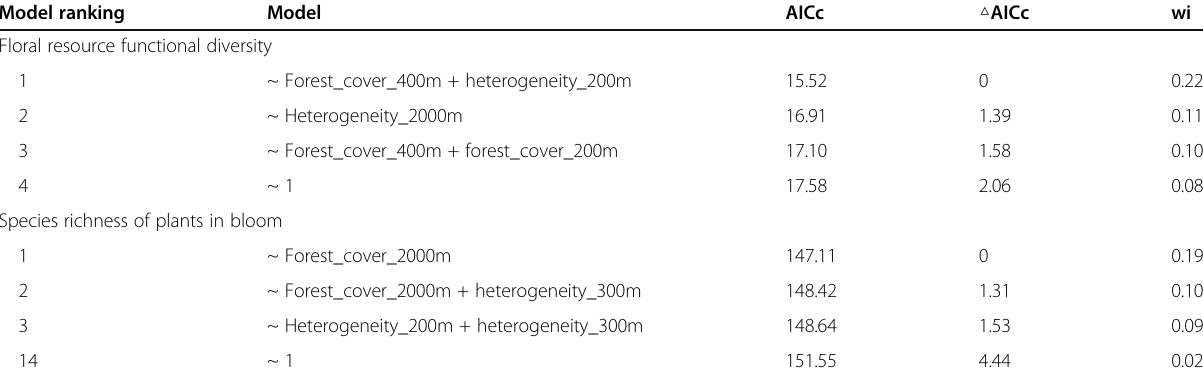
Table 3 Best ranked models and null model for floral resource functional diversity and species richness Model ranking